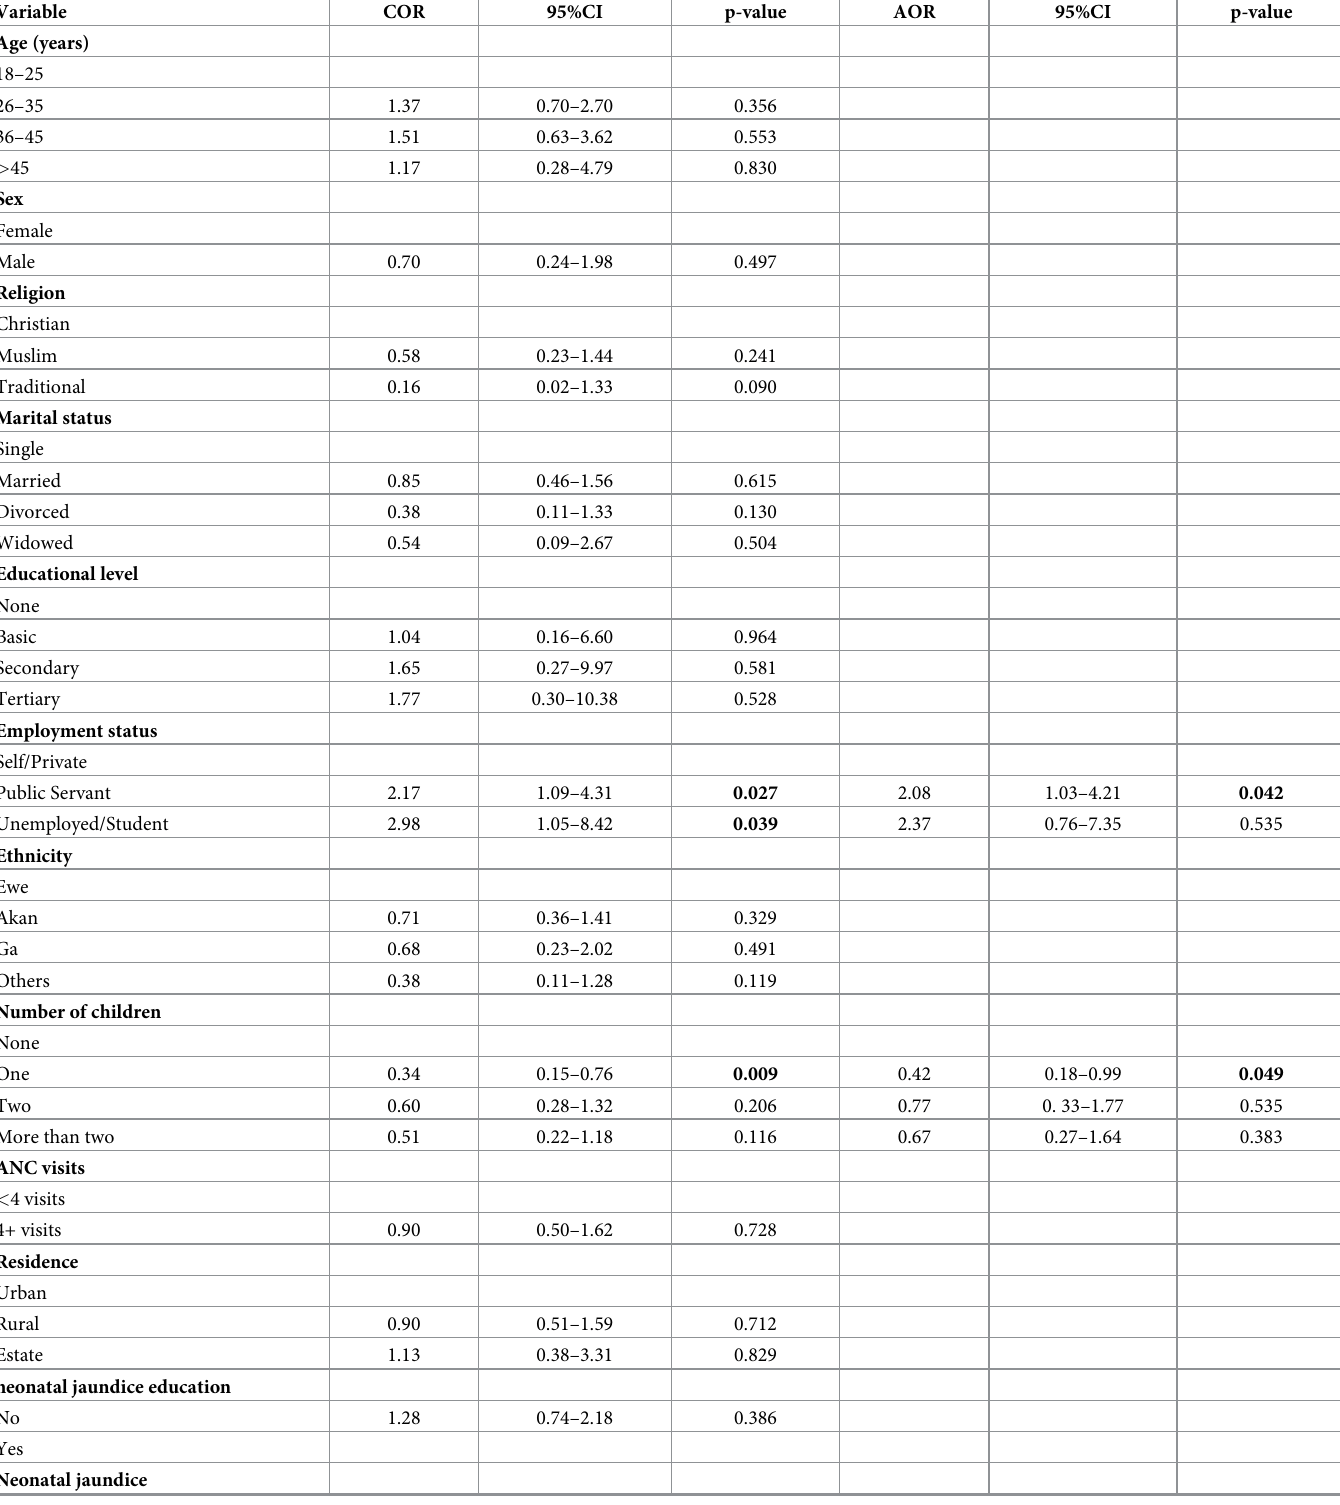
Table 6. Logistic regression results showing factors associated with caregivers’ attitude towards neonatal